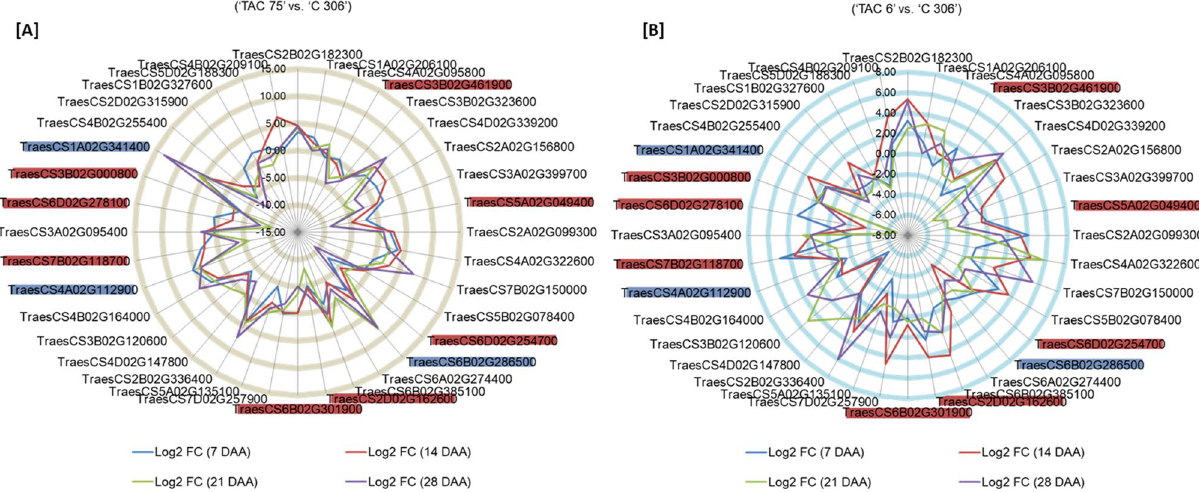
Figure 7. Differential gene expression (Log 2 fold change) data of 36 RING finger protein genes in three genotypes ‘TAC 75’, ‘TAC 6’ and parent ‘C 306’ at four seed developmental stages (7, 14, 21, and 28 DAA (days after anthesis) using qRT-PCR analysis. Differential gene expression analysis was performed in two groups; (A) Group 1 (‘TAC 75’ vs. ‘C 306) and (B) Group 2 (‘TAC 6’ vs. ‘C 306’). ‘TAC 75’ and ‘TAC 6’ are high and low amylose mutant lines derived from parent variety ‘C 306’ with amylose percent ~ 65%, ~ 7%, ~ 26%, respectively. The 11 candidate RING protein genes are marked with red color (down-regulated in high amylose line) and blue color (up-regulated in high amylose